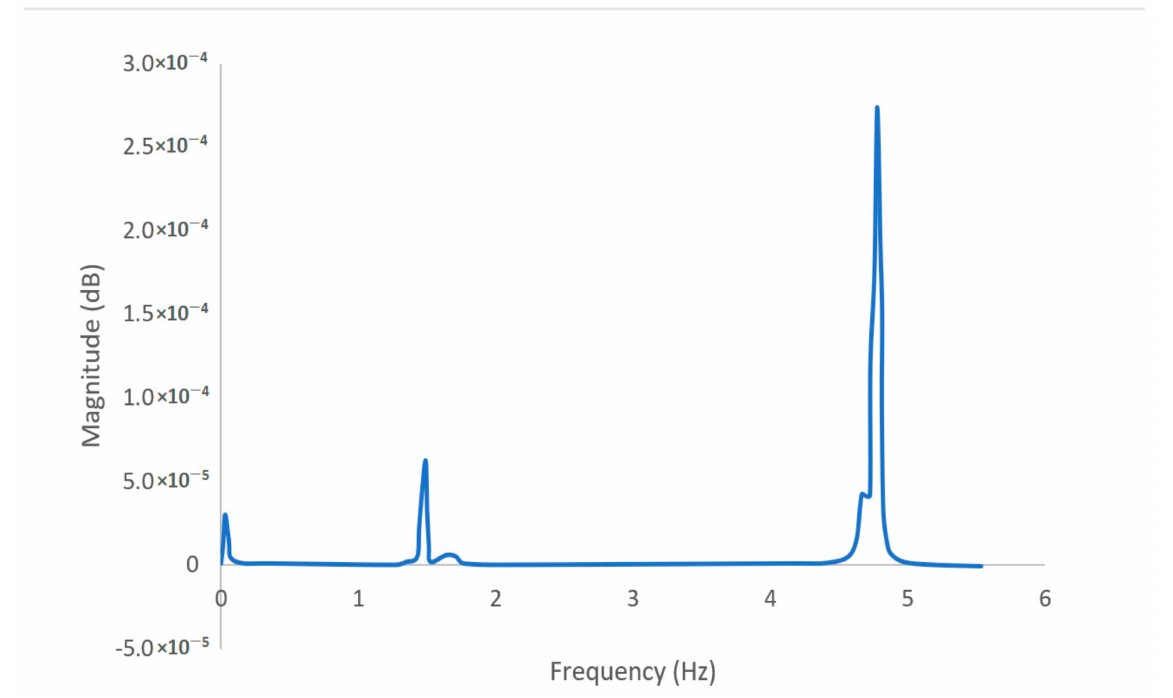
Figure 4. Fast Fourier transform of the bridge’s vertical acceleration.